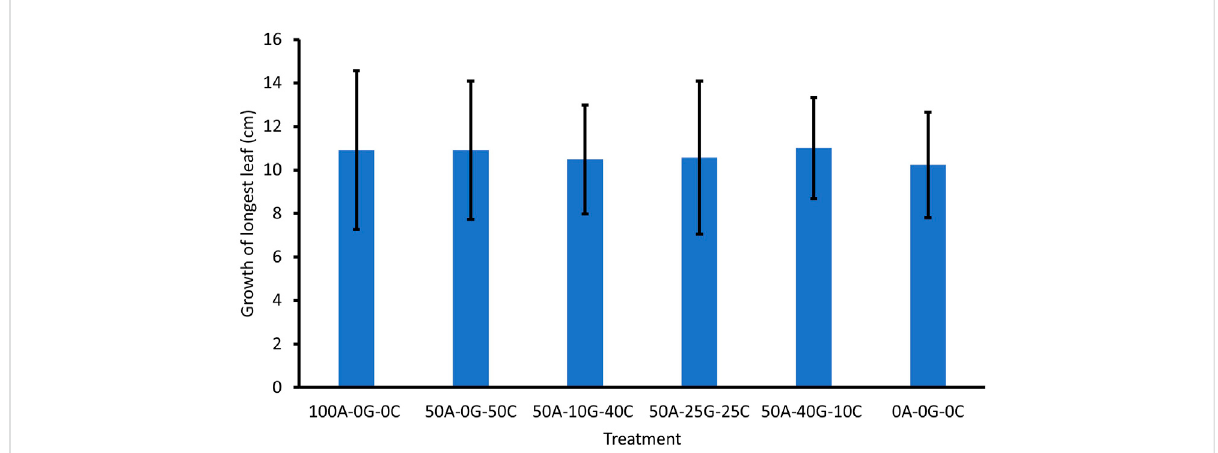
FIGURE 1 Effect of treatment group on mean seed germination. Error bars correspond to standard deviation. 100A-0G-0C (Positive control) — 100% sodium alginate, 0% glomalin, 0% Chlorella vulgaris 50A-0G-50C — 50% sodium alginate, 0% glomalin, 50% Chlorella vulgaris 50A-10G-40C — 50% sodium alginate, 10% glomalin, 40% Chlorella vulgaris 50A-25G-25C — 50% sodium alginate, 25% glomalin, 25% Chlorella vulgaris 50A-40G- 10C — 50% sodium alginate, 40% glomalin, 10% Chlorella vulgaris 0A-0G-0C (Negative control)- sterile glass beads with a similar diameter.